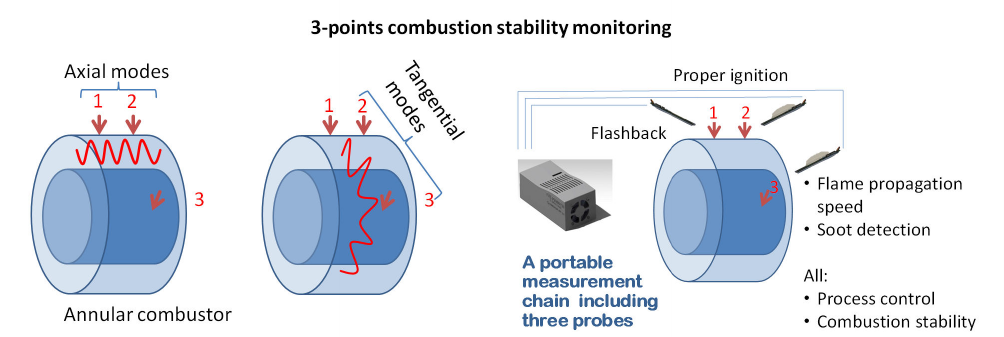
Figure 2. Combustion monitoring concept using three Rayleigh Criterion Probes (RCPs).